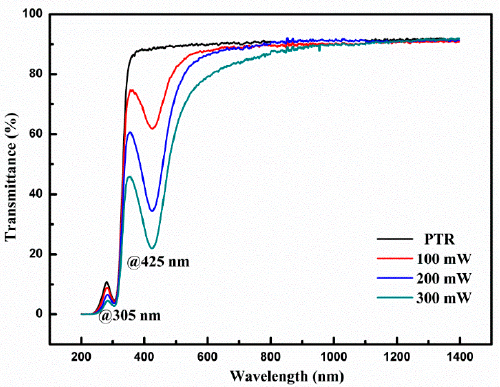
Figure 7. Transmission spectra of PTR glass showing intrinsic absorption at 305 nm by Ce 3+ dopants and the additional absorption at 425 nm due to silver clusters.